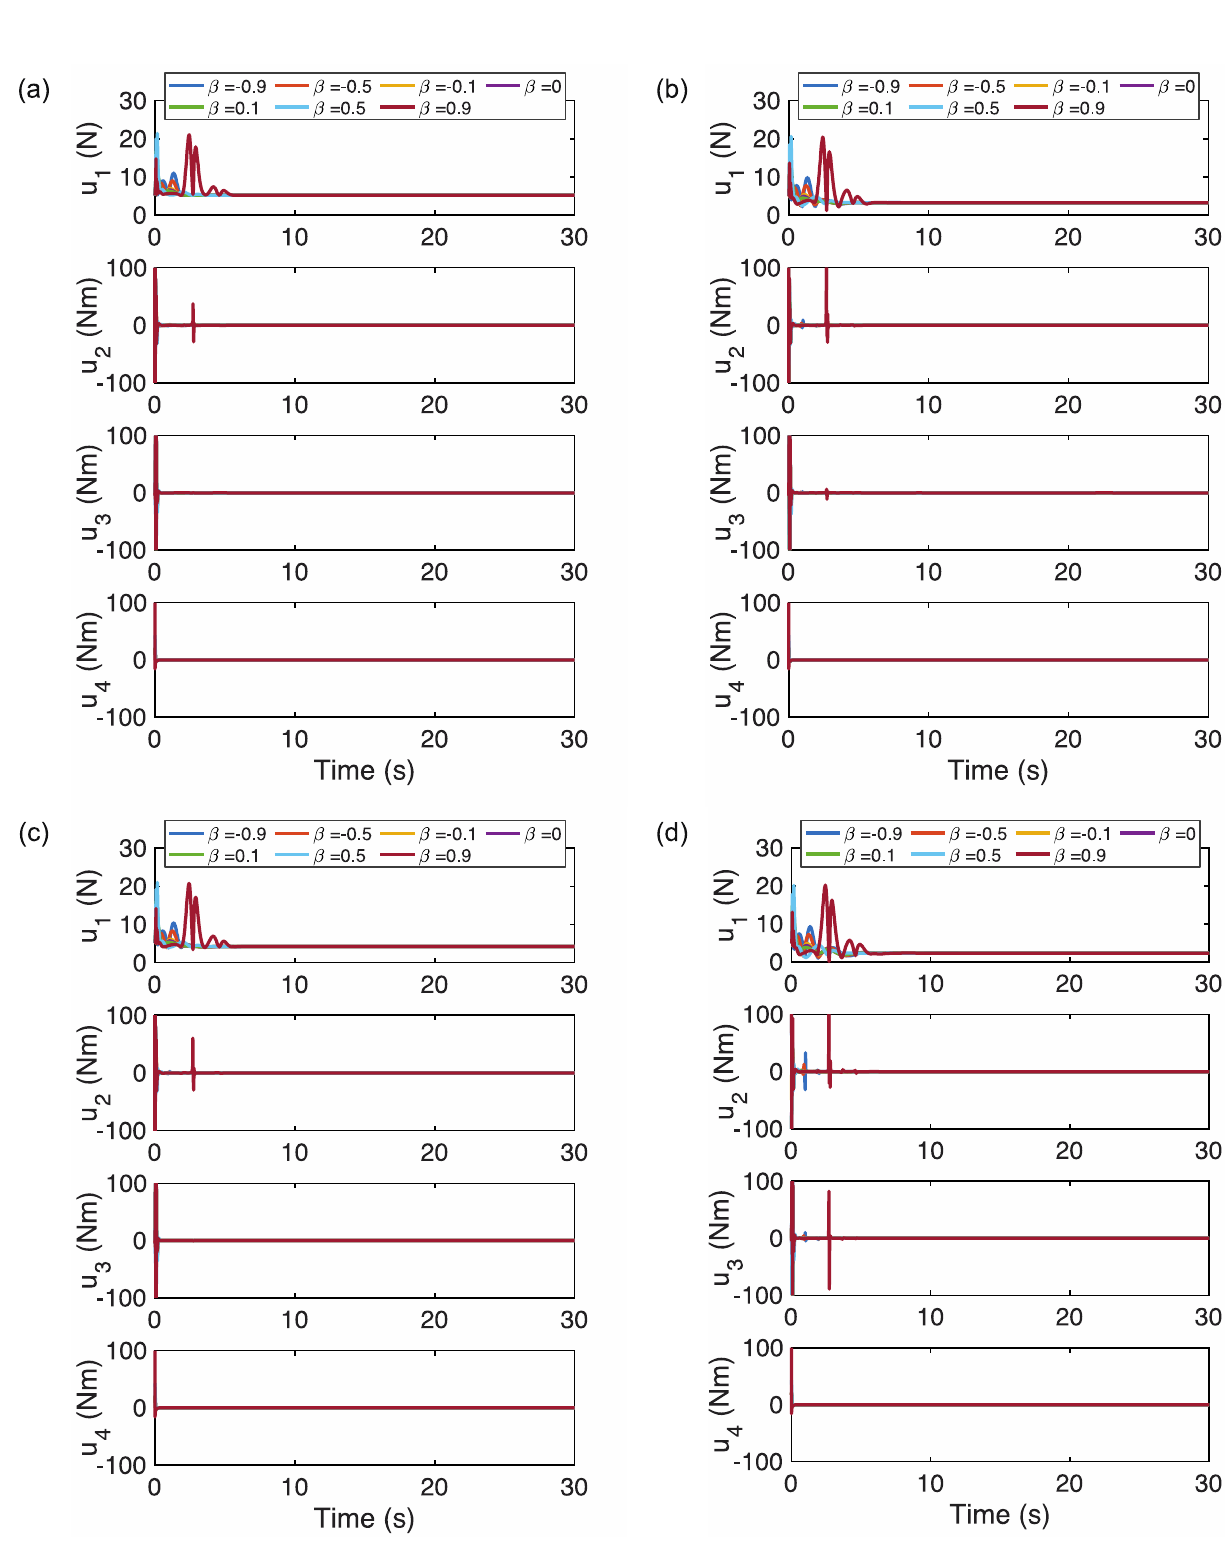
Figure 4. Simulated control inputs of the varying fractional orders in the proposed controller to uncertainty in the quadrotor dynamics with various payloads: ( a ) d 3 = 0 m/s 2 , ( b ) d 3 = 2 m/s 2 , ( c ) d 3 = 4 m/s 2 , ( d ) d 3 = 6 m/s 2 . (Assume that d 1 = d 2 = d 4 = d 5 = d 6 = 0 and no input time delay.)